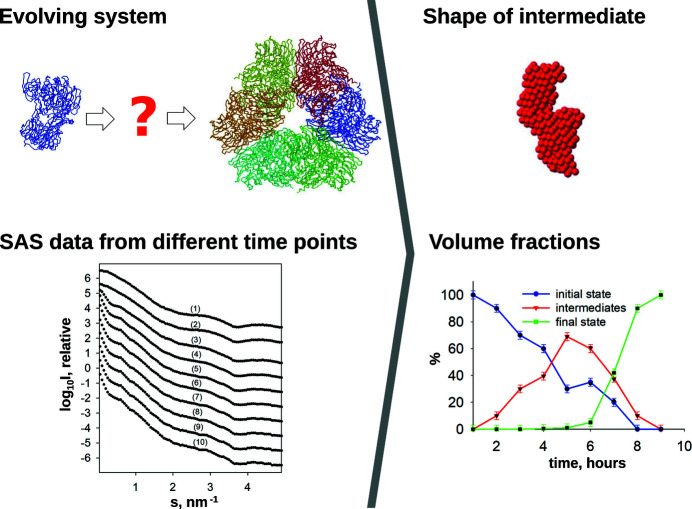

DAMMIX reconstructs the structure of an unknown intermediate in an evolving system, on the basis of known initial and final states, and experimental SAXS data collected at different time points. The volume fractions of the initial, intermediate and final states at each time point are also derived.